Question: How would you classify this visualization?
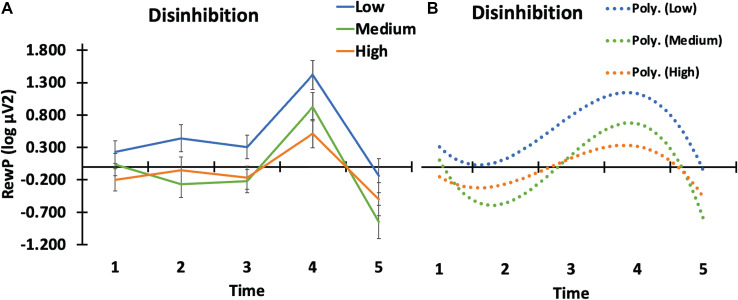
Answer: bar